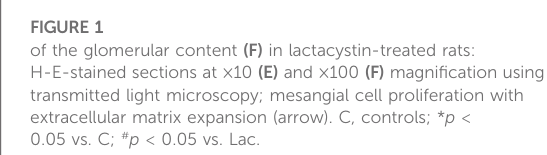
FIGURE 1 of the glomerular content (F) in lactacystin-treated rats: H-E-stained sections at ×10 (E) and ×100 (F) magni fi cation using transmitted light microscopy; mesangial cell proliferation with extracellular matrix expansion (arrow). C, controls; * p < 0.05 vs. C; # p < 0.05 vs.